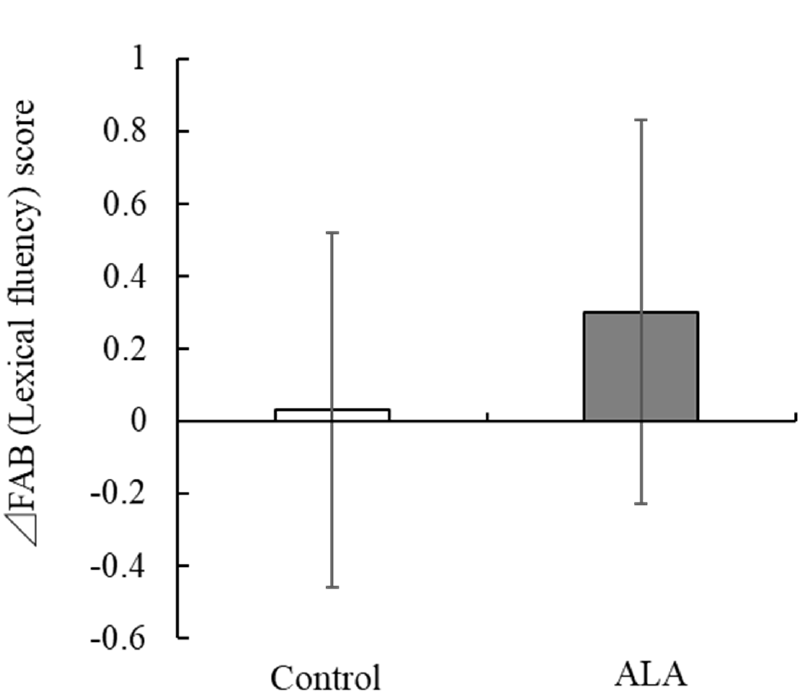
Figure 1. Effect of ALA intake on FAB (Lexical fluency) scores. Mean changes ( ∆ ) in the FAB (Lexical fluency) scores after 12 weeks of intervention in the ALA and control groups. Bar represents the mean ± SD. ALA, alpha-linolenic acid; FAB, frontal assessment ba tt ery.